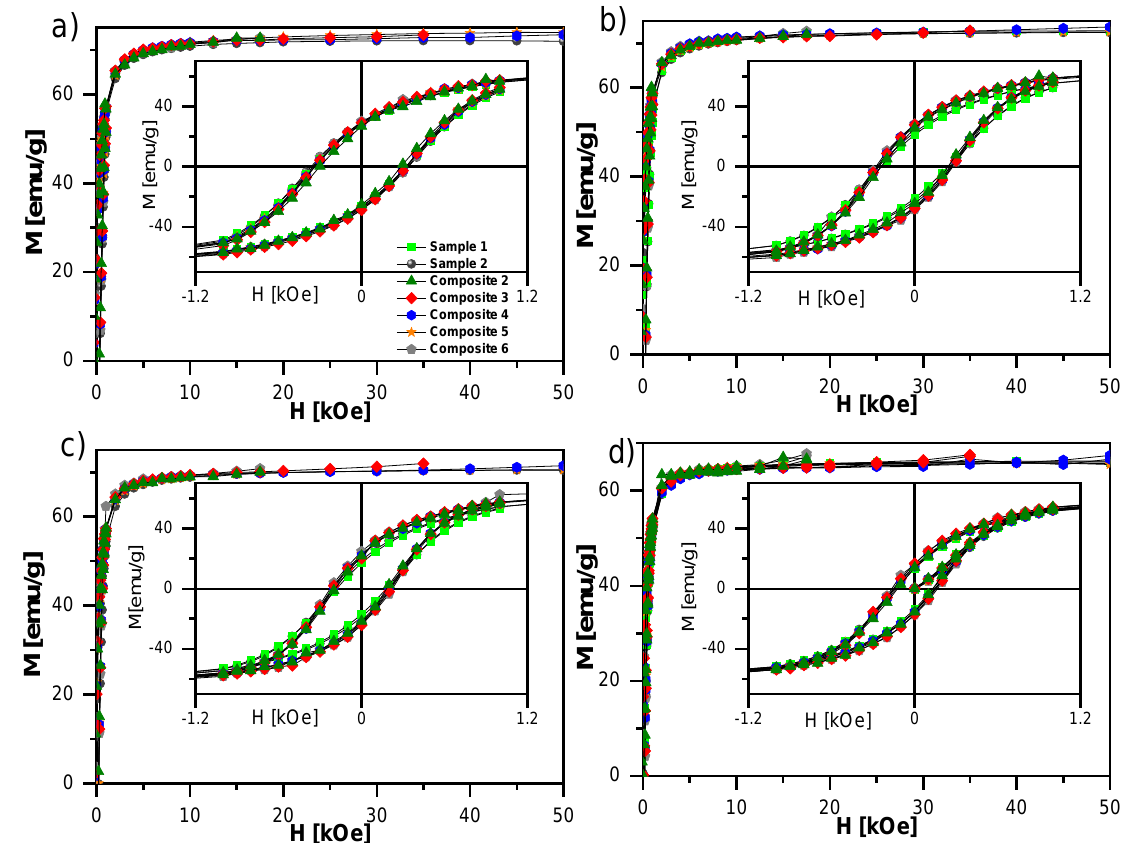
Figure 17. Magnetization vs. external magnetic field and magnetic hysteresis (insets) for Samples 1 – 2 and Composites 2 – 6 measured at 10 K ( a ), 100 K ( b ), 200 K ( c ), and 300 K ( d ). All values were scaled to values for the γ -Fe 2 O 3 nanoparticles (Sample 1). The solid lines in all figures are a guide for the eye. The legend in graph ( a ) is the same for all graphs.